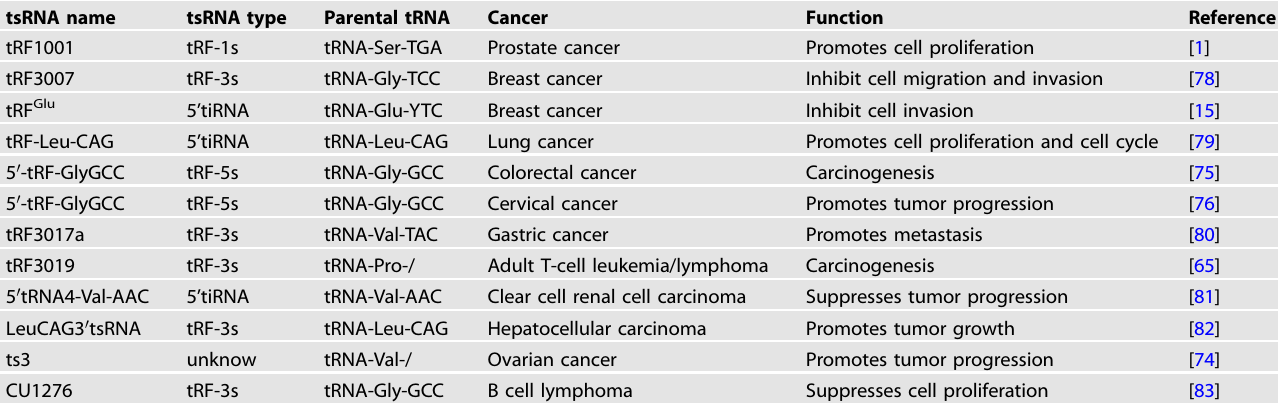
Fig. 1 Source and structure of different types of tsRNA. tRF-1s is derived from pre-tRNA by ELCA2- mediated cleavage in the nucleus. tRF-3s is derived from the 3 ′ -end of mature tRNA and can be divided into two types. tRF-5s can be produced by Dicer and ANG cleavage, starting from the 5 ′ -end of the mature tRNA, including the complete structure of the 5 ′ -end, and terminating before the anticodon loop tRF-5s can be divided into three sub-types: tRF-5a, tRF-5b, and tRF-5c. The tiRNA is derived from mature tRNA by ANG-mediated cleavage in the cytoplasm and can be divided into 5 ’ tiRNA and 3 ’ tiRNA. tRF-2s/i-tRFs are generated from the anticodon loop of mature tRNA. Table 1. The role of tsRNA in